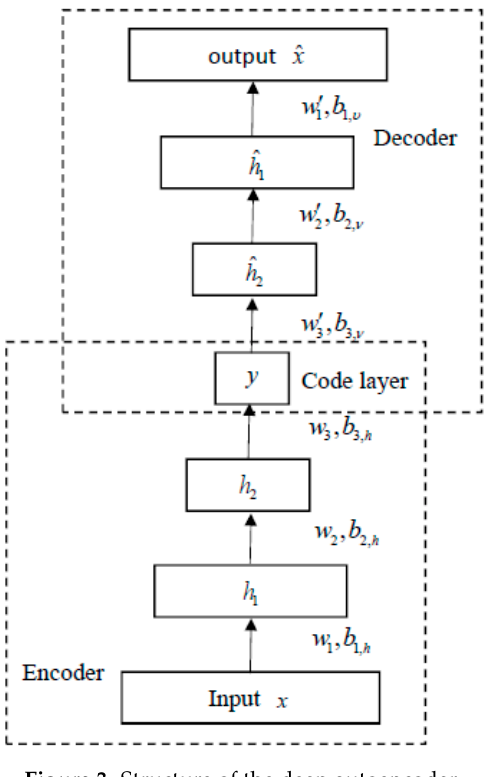
Figure 3. Structure of the deep autoencoder.